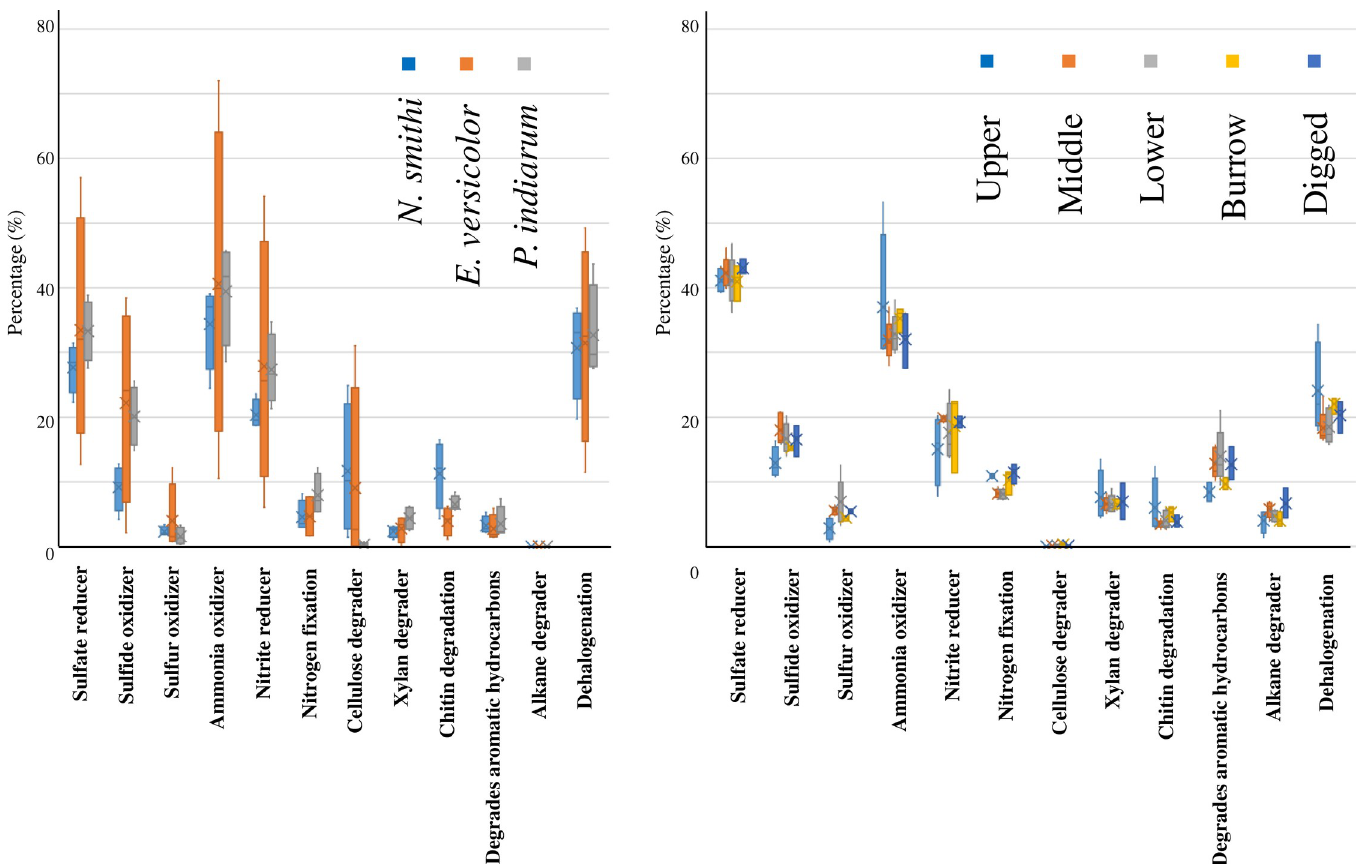
Fig 4. Phenotype prediction of sediment region and intestinal bacteria in mangrove crabs. The Y axes represent the percentage of OTUs assigned in METAGENassist, whereas the X axes represent the phenotype. Each bar represents the data for samples. A) Crab intestines. B) Sediment regions.